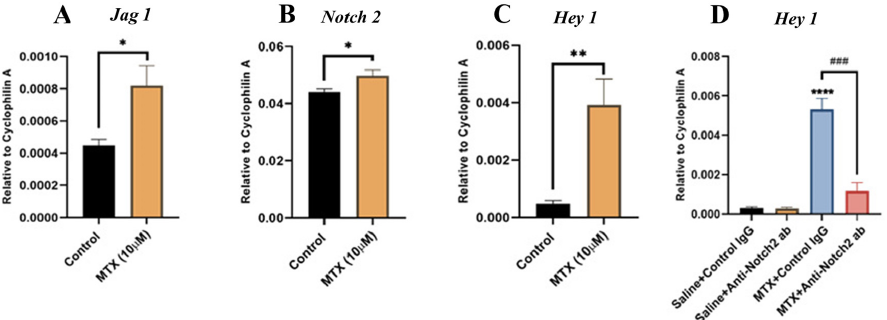
Figure 5. MTX treatment effects on the Notch2 ligand Jag1 , Notch2 , and the Notch target gene Hey1 mRNA expression and the role of Notch2 signalling in MTX-induced Hey1 induction in cultured rat bone marrow-derived endothelial cells (BMECs). Quantitative real-time PCR gene expression analyses of ( A ) Jag1 , ( B ) Notch2 , ( C ) Hey1 , using RNA isolated from control and MTX-treated (10 µ M for 24 h) BMECs. ( D ) Quantitative real time PCR for Hey1 in BMECs treated for 24 h with Saline+Control IgG, Saline+Anti-Notch2 antibody (ab), MTX+Control IgG, or with MTX+Anti-Notch2 antibody. * p < 0.05, ** p < 0.01, and **** p < 0.0001 compared to control IgG; and ### p < 0.001 compared between MTX treated groups. All results are shown as mean ± SEM from three independent experiments.